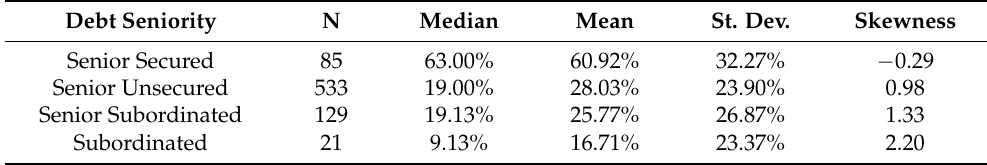
Table 3. Summary statistics of recovery rates according to the seniority of the defaulted bond.